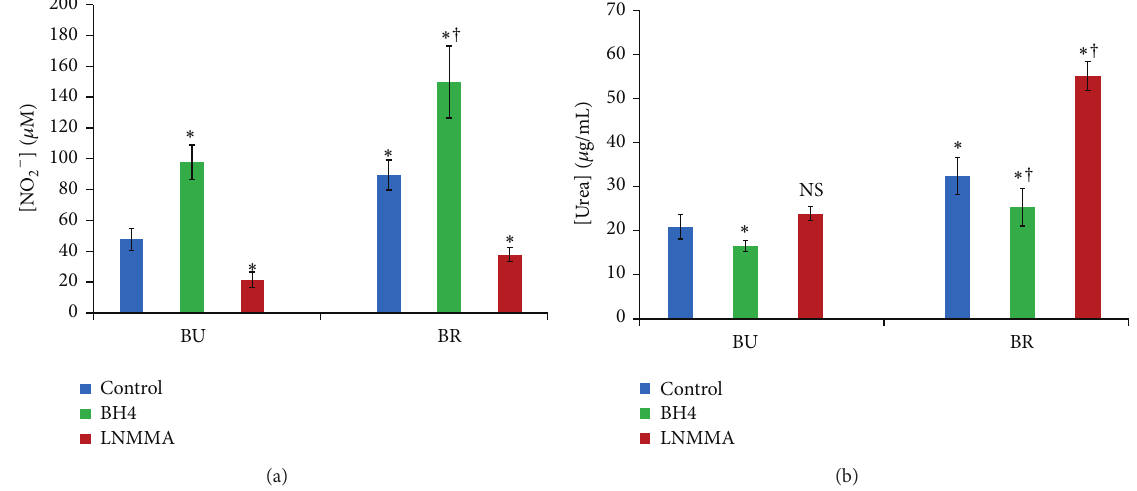
Figure 8: L-NMMA and BH4 effect on nitric oxide (a) and urea (b) concentrations in patients’ PBMC cultures supernatants ( 𝑛 = 29 ) in presence of patients’ plasma at 20% (BU: uveitis, BR: arthritis, ∗ : 𝑃 < 0.05 versus control cultures, and † : 𝑃 < 0.05 between patients